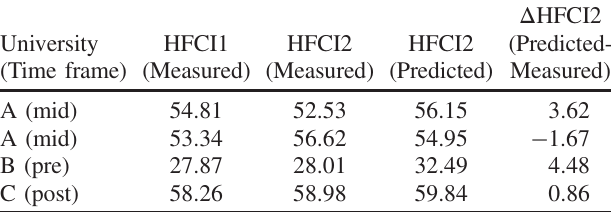
TABLE VI. Measured HFCI scores and predicted HFCI2 scores. The HFCI2 predicted scores are obtained by applying the linear conversion model to the measured HFCI1 scores. The differences between predicted and measured HFCI2 scores are also calculated and listed to the right. (Pre: administered as pretest, Mid: administered during the middle of the semester, and Post: administered as posttests).